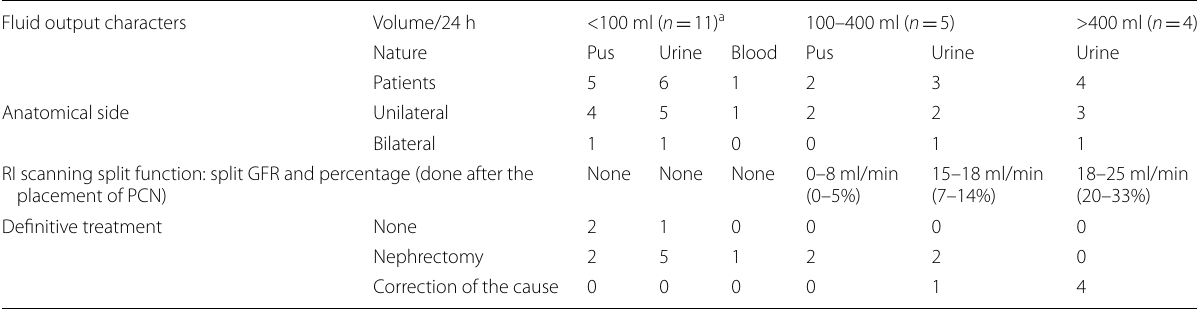
RI radio-isotope scanning, GFR glomerular filtration rate, PCN percutaneous nephrostomy a One patient in group 1 died due to septicemia that followed immediately the placement of nephrostomy tube. Nephrectomy was done for 7 of the 11 patients. The other 4 patients were unfit for surgery and followed up with exchange upon being slipped, besides regular dialysis